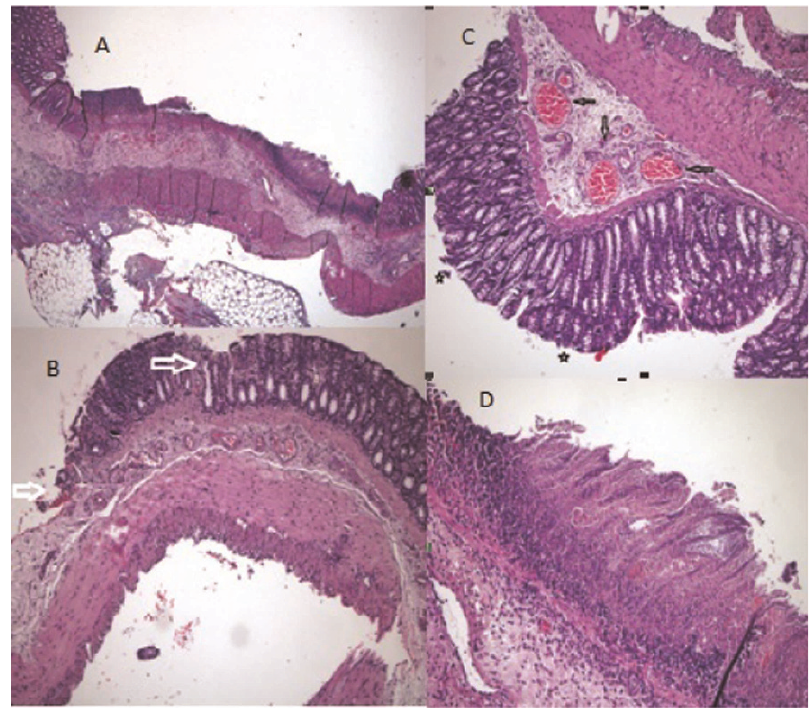
Figure 3 - Group histopathology. A . Common massive areas of epithelial detachment and presence of transmural necrosis. [‘‘Chiu’’ classification grade 5] (H&E x40). B . Massive areas of epithelial detachment (shown with an arrow) [‘‘Chiu’’ classification grade 3] (H&E x100). C . Subepithelial ‘‘Gruenhagen’s space’’ (shown with an asterisk) and capillary congestion (shown with an arrow) [‘‘Chiu’’ classification grade 1] (H&E x200). D . Area of mucosal ischemic necrosis (H&E